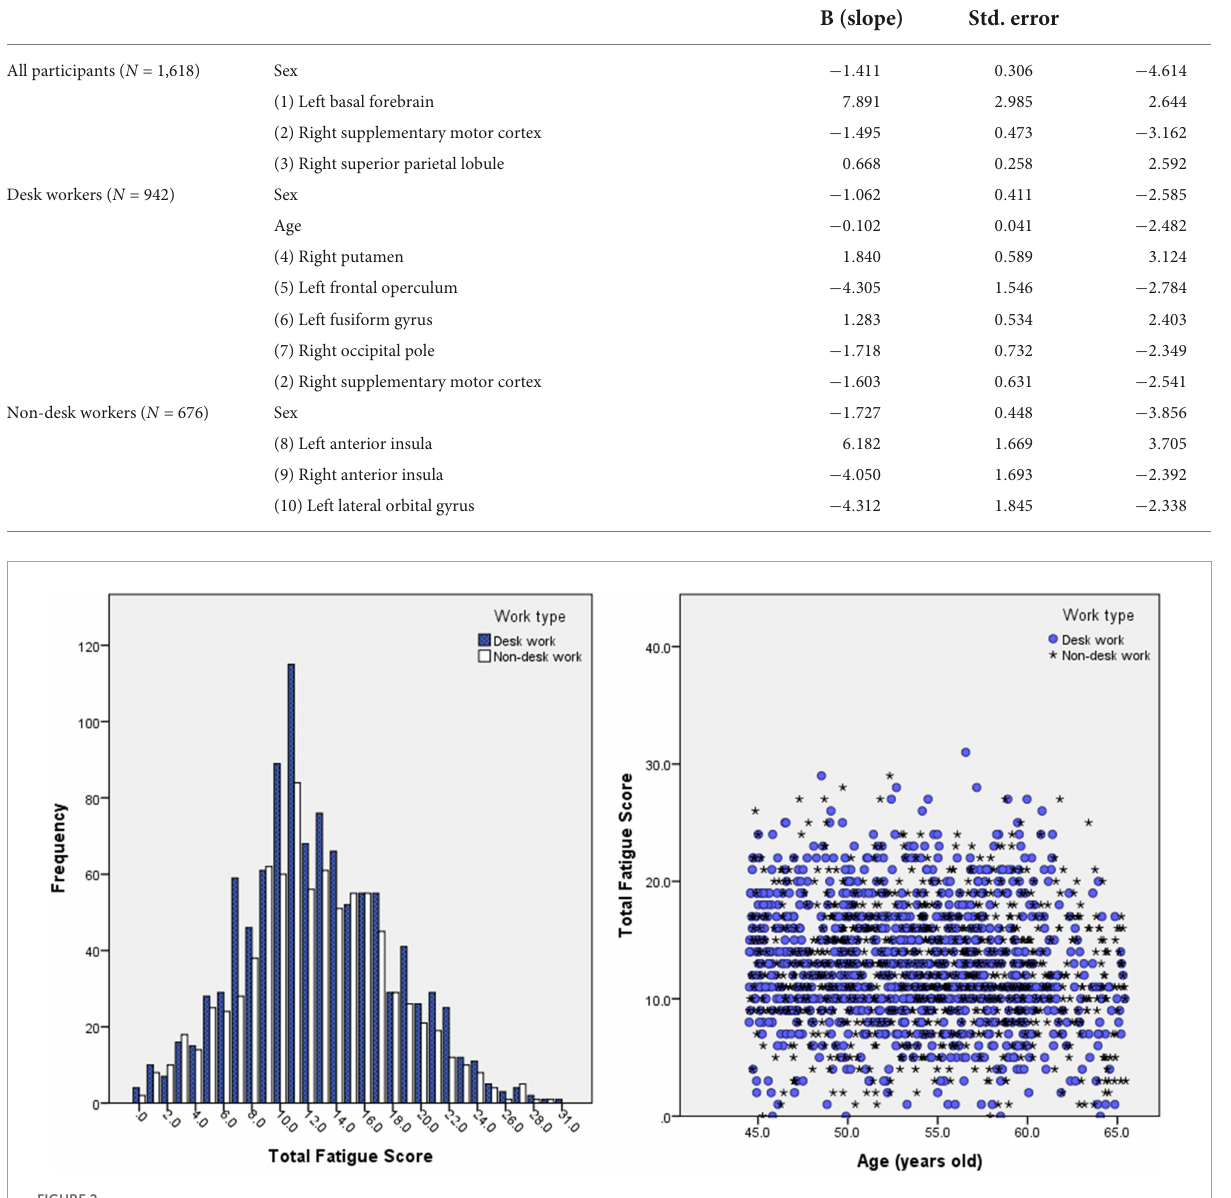
FIGURE2 Histogram of CFQ (total fatigue score) result’s distribution for desk work and non-desk work participants (left) and scatter plot of CFQ score results vs. age. Both left and right figures show no significant and observable difference in CFQ scores between desk work and non-desk work